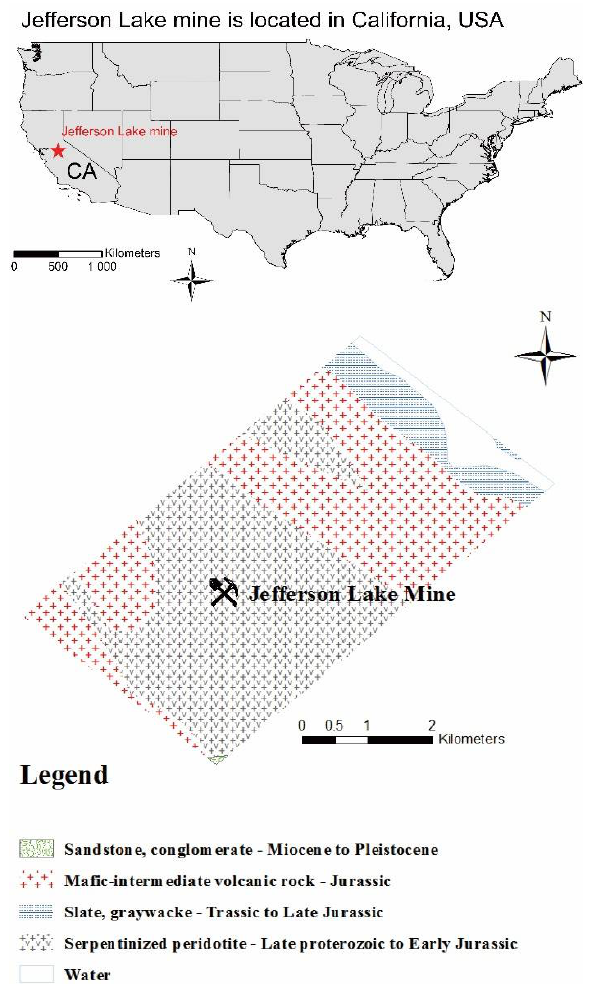
Figure 1. Location ( upper ) and regional USGS geology map ( bottom ) of the study area .